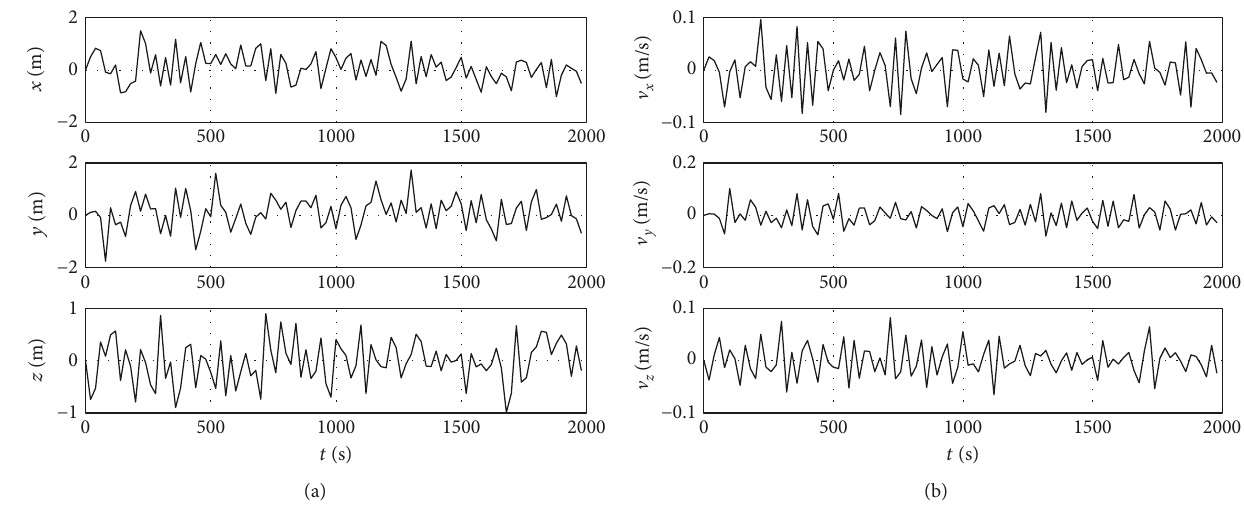
Figure 5: Estimation error in optimal formation. (a) Estimation error of position. (b) Estimation error of velocity. Table 3: Parameters of USVs and target in general formation. Initial position Forward speed Vehicle Heading ( ° ) Pitch ( ° (m) (knots)